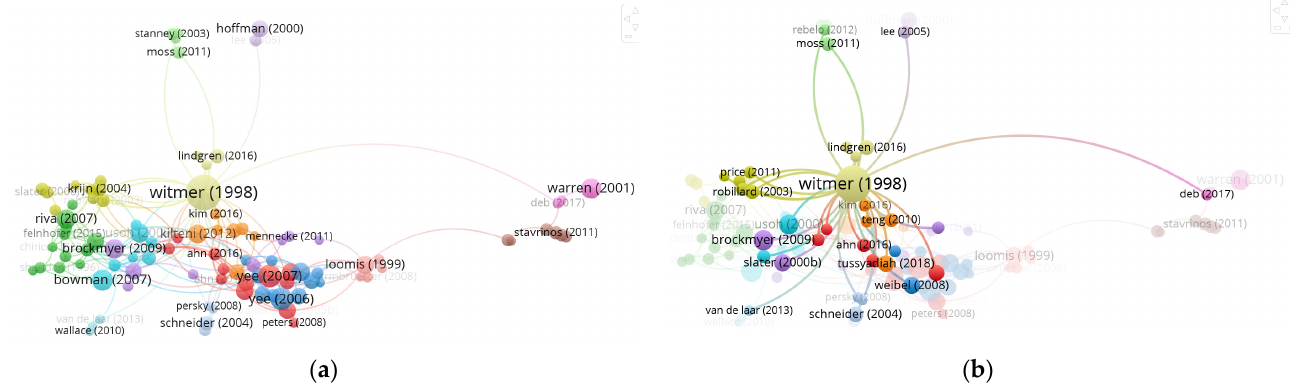
Figure 10. ( a ) The citation analysis map of influential publications; and ( b ) relationships involving the most influential publication, Witmer and Singer (1998) in the citation analysis map. Table 8. Top three most influential publications with the strongest relationship resulting from cita- tion analysis.